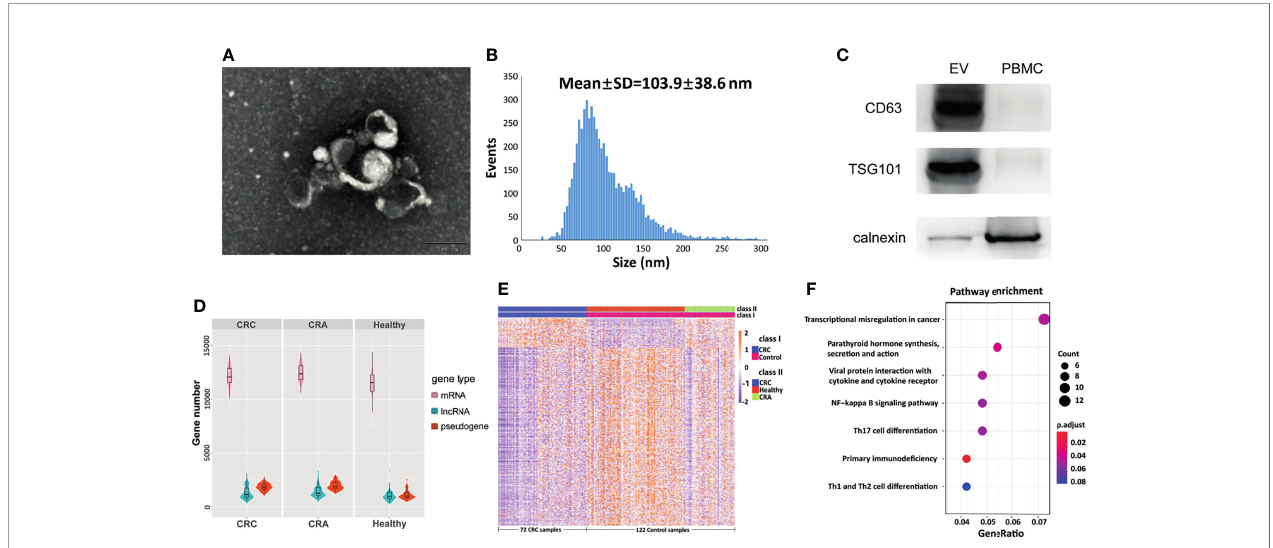
FIGURE 1 | Plasma EVs and exLR-seq. (A) Photograph of EVs using a TEM. (B) Size distribution of EVs. (C) Western blot analysis of EV markers TSG101 and CD63 in PMBC and EVs. (D) Amount of exLRs for each sample among CRC, CRA, and healthy individuals. (E) Unsupervised hierarchical clustering of the exLRs differentially expressed between CRC and control (class I); CRC, healthy, and CRA (class II). (F) KEGG pathway enrichment analysis for differentially expressed